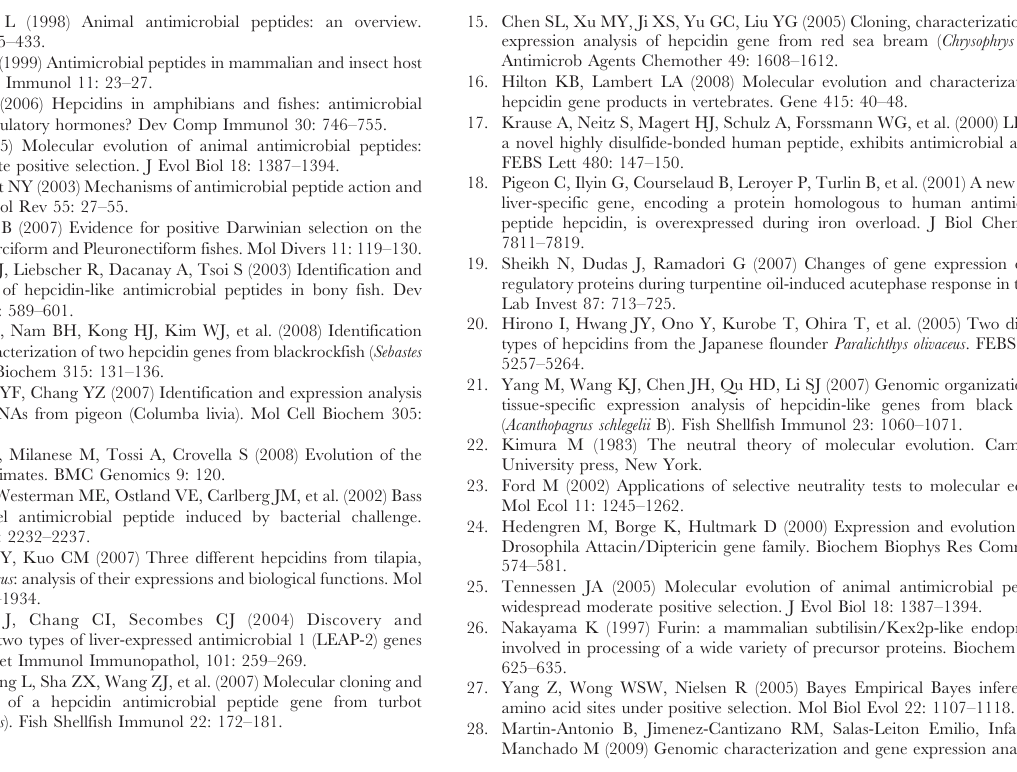
Figure S1 Alignment of deduced amino acid sequences of the miiuy croaker hepcidin gene with those of other species. Gaps used to maximize the alignment are shown by dashes. Conserved cysteins are shown in black background, the box indicates RX(K/R)R cleavage motifs. (JPG) Figure S2 Nucleotide sequences and amino acid se- quences for hepcidin alleles of miiuy croaker. Dots indicate identity with the top sequences. (JPG) Figure S3 Amino acid sequence comparison among fish HAMP2 sequences. Positively selected sites identified using M8 model (Table 1) are shaded in black background. (JPG) Table S1 Percent identity of amino acid ( aa ) sequences calculated versus the miiuy croaker HAMP sequence. Table S2 Genomic organization of hepcidin genes of different fish